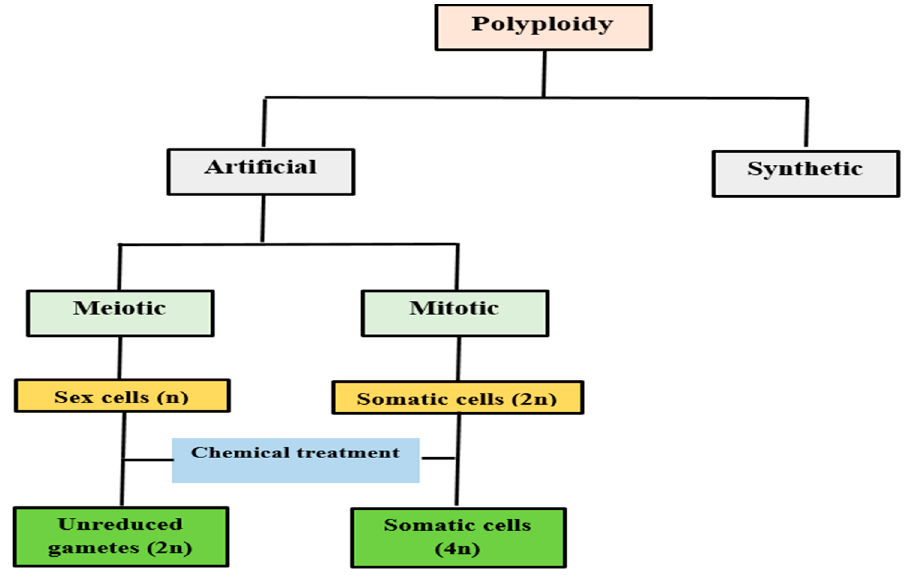
Figure 1. Systematic diagram of polyploidy induction through artificial means.